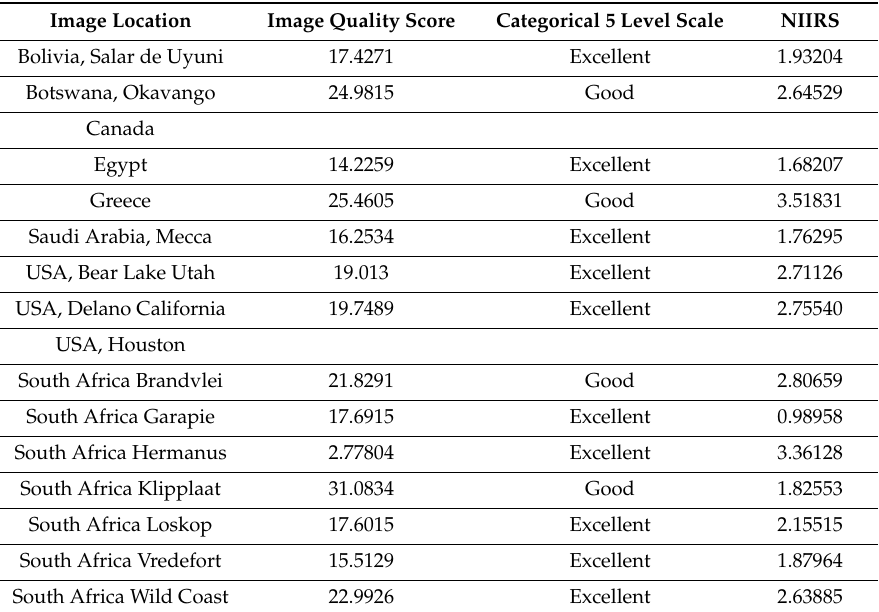
Table 2. Landsat 8 image quality and interpretability assessment